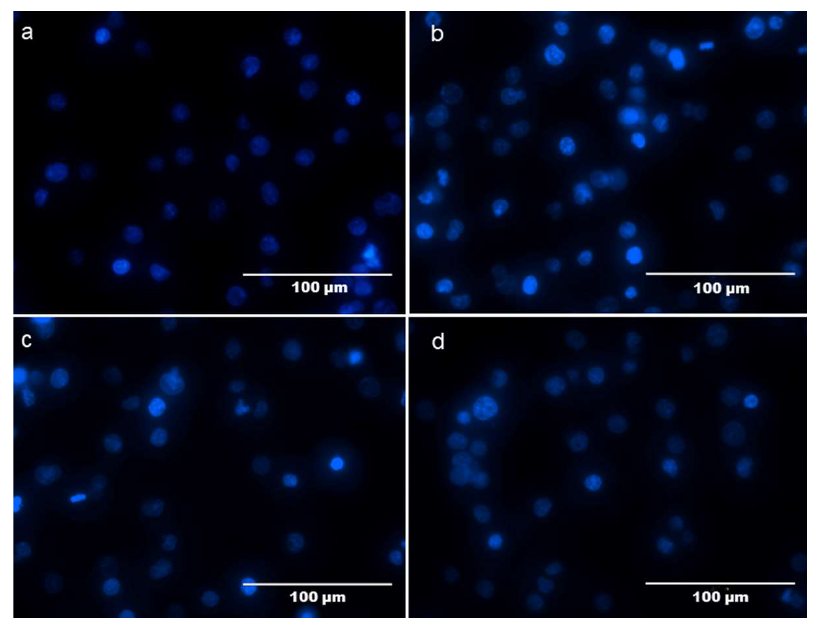
Figure 8. Fluorescent photo micrographs after staining with Hoechst 33342. ( a ) Untreated control. ( b ) Cells exposed to 400 µM of H 2 O 2 . ( c , d ) Cells were treated with NMCP-2 (5, 25 µg/mL) for 24 h followed by exposure to 400 µM H 2 O 2 .